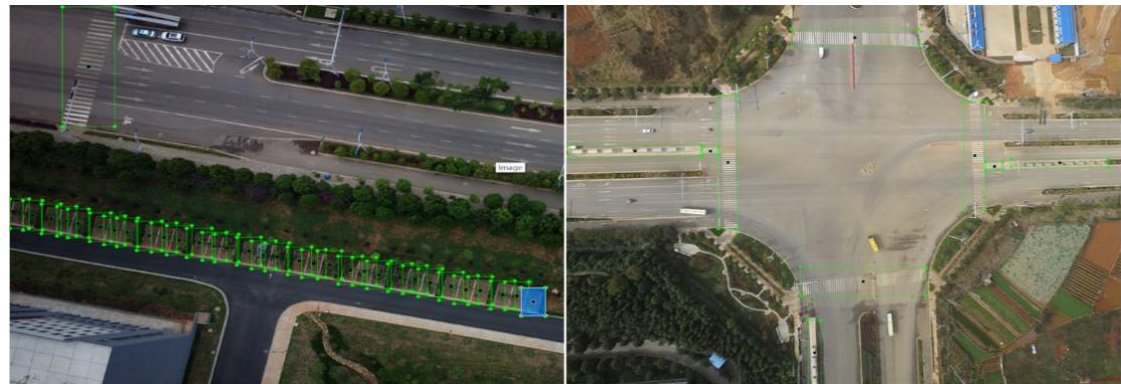
Figure 3. Sample datasets.